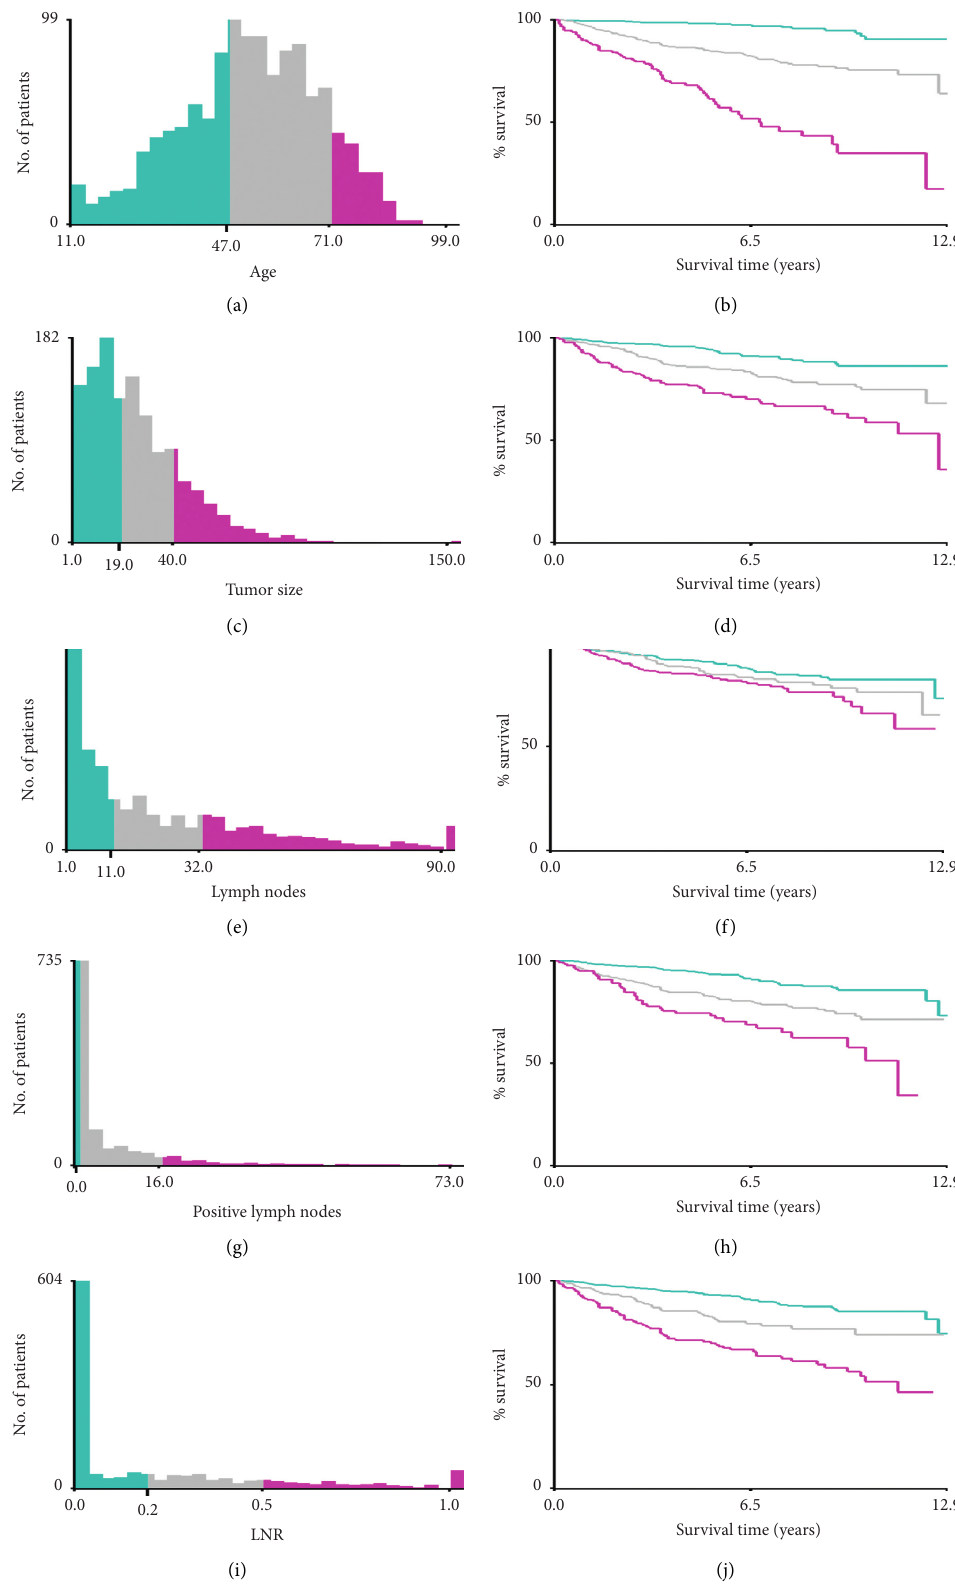
Figure 1: Identification of optimal cutoff values of age (a, b), tumor size (c, d), the number of regional lymph nodes by pathological findings (e, f), pLNs (g, h), and LNR (i, j) via X-tile software analysis. Optimal cutoff values of age were identified as 47 and 71 years based on overall survival. Optimal cutoff values of tumor size were identified as 19mm and 40 mm based on overall survival. Optimal cutoff values of the number of regional lymph nodes by pathological findings were identified as 11 and 32 based on overall survival. The optimal cutoff values of pLNs were 1 and 16 based on overall survival. The optimal cutoff values of LNR were 20% and 50% based on overall